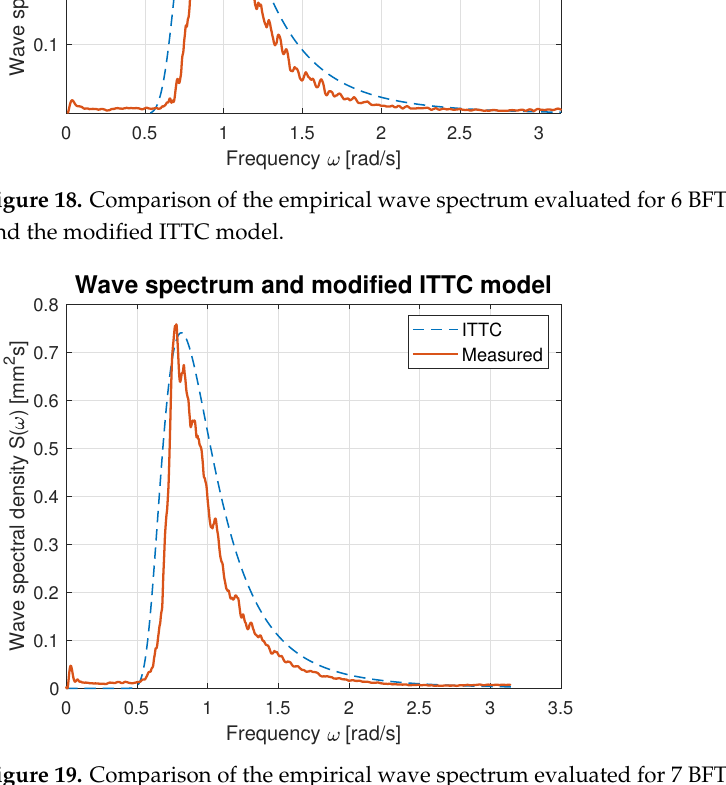
Figure 19. Comparison of the empirical wave spectrum evaluated for 7 BFT wind force in ship scale and the modified ITTC model.